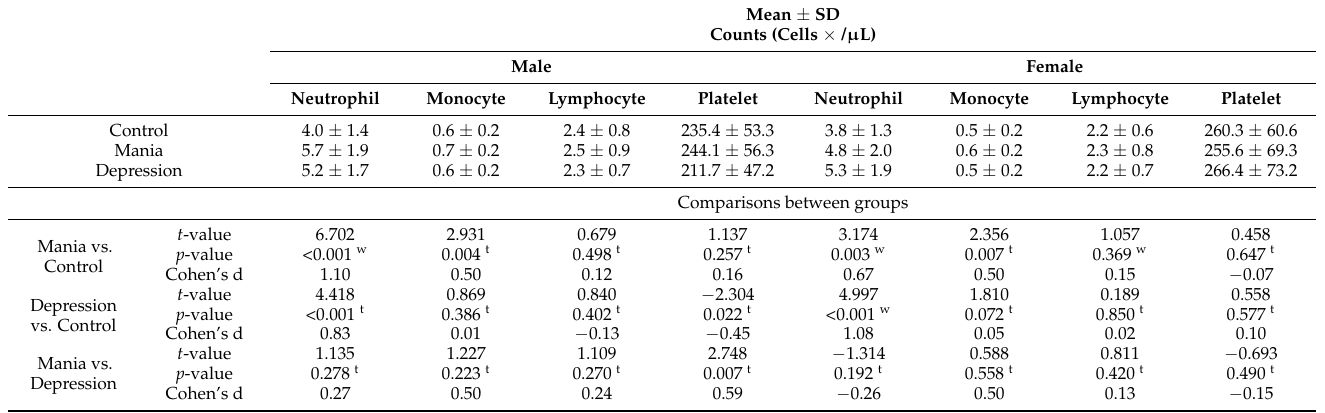
Table 4. White blood cells and platelets in male and female patients with mania or depression and healthy controls. Values are presented as mean ± SD.